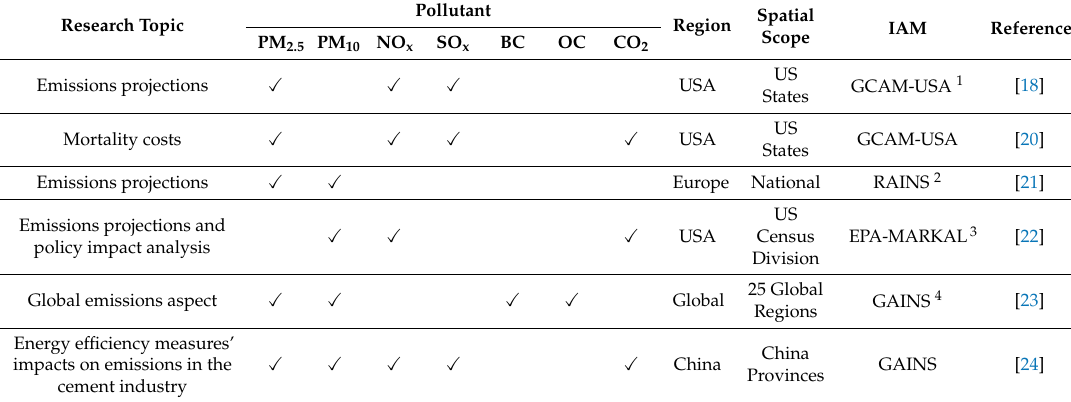
Table 1. Previous studies on anthropogenic PM2.5 emissions using